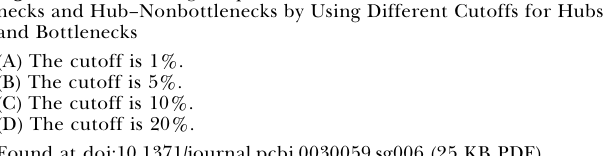
Figure S6. The Average Expression Correlation for Nonhub–Bottle- necks and Hub–Nonbottlenecks by Using Different Cutoffs for Hubs and Bottlenecks (A) The cutoff is 1%. (B) The cutoff is 5%. (C) The cutoff is 10%. (D) The cutoff is 20%. Figure S7. The Average Expression Correlation for Hub–Bottlenecks, Nonhub–Bottlenecks, Hub–Nonbottlenecks, and Nonhub–Nonbottle- necks by Using Different Cutoffs for Hubs and Bottlenecks (A) The cutoff is 1%. (B) The cutoff is 5%. (C) The cutoff is 10%. (D) The cutoff is 20%. Found at doi:10.1371/journal.pcbi.0030059.sg007 (37 KB PDF). Table S1. Number of Proteins in Each of the Four Categories in Both Interaction and Regulatory Networks Table S2. Essentiality of Different Categories of Proteins in Phosphorylation, Metabolic, and Genetic Networks Table S3. Occurrence of Different Biological Process Annotations from the Gene Ontology Annotation Scheme in the Four